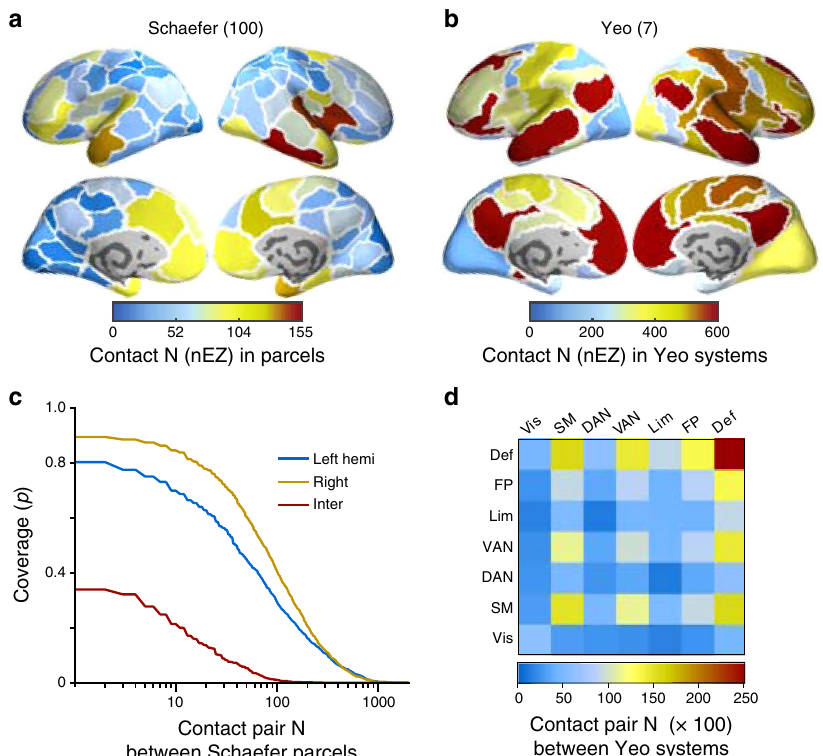
Fig. 1 Anatomical sampling statistics and coverage for assessment of cortical interactions. a Numbers of SEEG electrode contacts in the non- epileptogenic zone (nEZ) across 100 parcels (Schaefer) and b seven functional systems (Yeo). c Population level cortical interaction coverage in terms of the total number of SEEG contact pairs in Schaefer parcellation within the left and right hemispheres, and between them (Inter), and d among the Yeo functional systems (Vis visual, SM somatomotor, DAN dorsal attention, VAN ventral attention, Lim limbic, FP fronto-parietal, Def default, both hemispheres (Fig. 1a) and of seven canonical functional brain systems de fi ned by functional magnetic resonance imaging (fMRI) intrinsic con- nectivity mapping 41,42 (Fig. 1b, more details of sampling statistics see Supplementary Fig. 1).